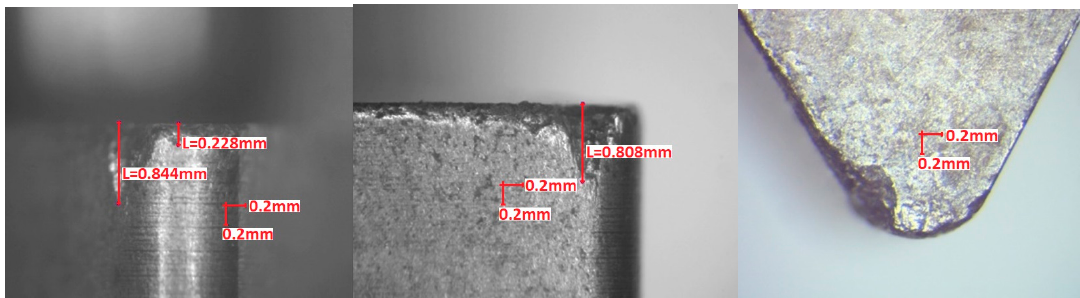
Figure 9. Unimplanted TNGA 160408E (IS9) edge after turning test ( VB N = 1.8 mm, VB C = 0.8 mm).